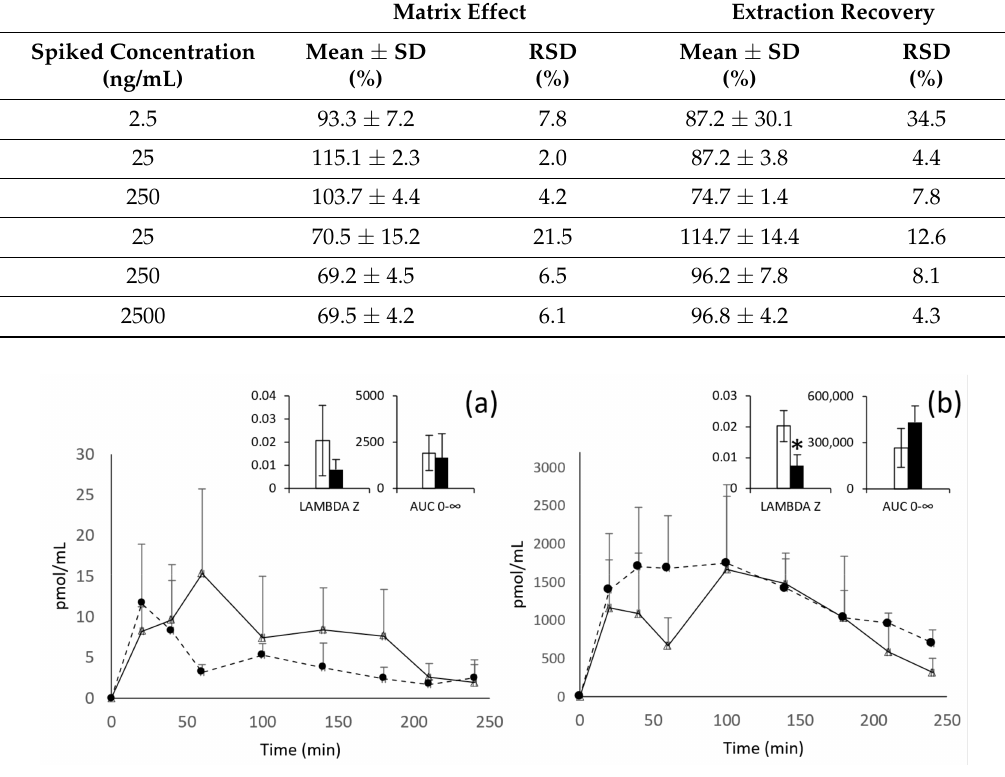
Figure 2. Kinetic profiles of ε Vin ( a ) and ε VG ( b ) after oral administration of 20 mg/kg bw of free (white triangles) or encapsulated (black circles) ε Vin. Data are expressed in pmol/mL of plasma + standard deviation (SD). Lambda z and AUC 0– ∞ are expressed in min − 1 and pmol/mL/min, respectively. Comparisons between free (white) or encapsulated (black) forms administration were analyzed by Student’s t -test (* p < 0.05). Table 3. Pharmacokinetic parameters of ε Vin and ε VG in rat plasma after oral administration of free or encapsulated form. T max , T 1/2 and mean residence time (MRT) were expressed in minutes, C max in pmol/mL, AUC in pmol/mL/min and Lambda z in min − 1 . Comparisons between encapsulated or free form administration were analyzed by Student’s t -test (* p <